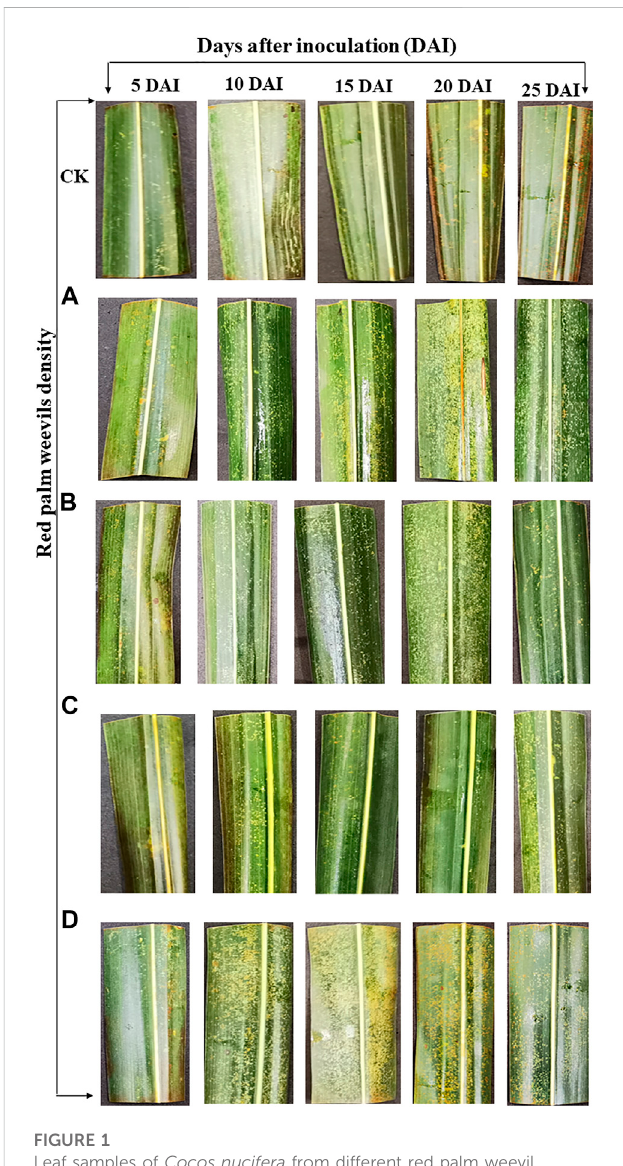
FIGURE 1 Leaf samples of Cocos nucifera from different red palm weevil (RPW) population densities and sampling times after infestation used for transcriptome pro fi ling. Where, CK = no RPW; (A) = 5 males and seven females; (B) = 10 males and 14 females; (C) = 15 males and 21 females; (D) = 20 males and 28